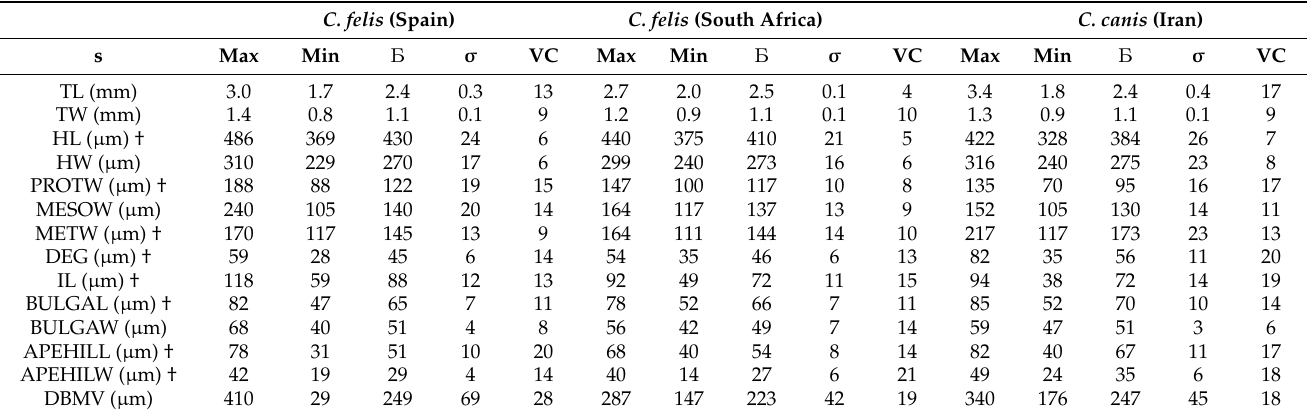
Table 3. Biometrical data of females of Ctenocephalides felis and C. canis isolated from Canis lupus familiaris from Spain, South Africa and Iran.